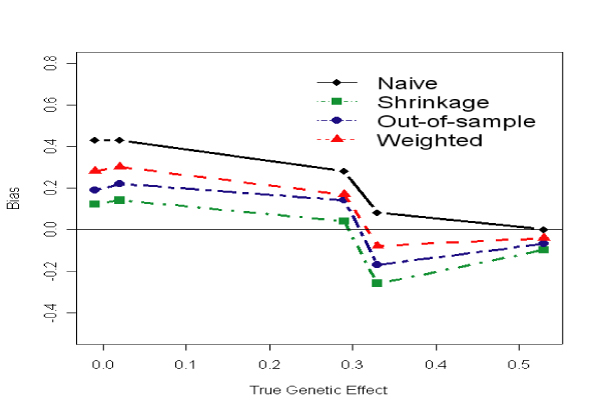
Bias comparisons of the naïve estimate and the three resampling-based estimates for SNP markers.